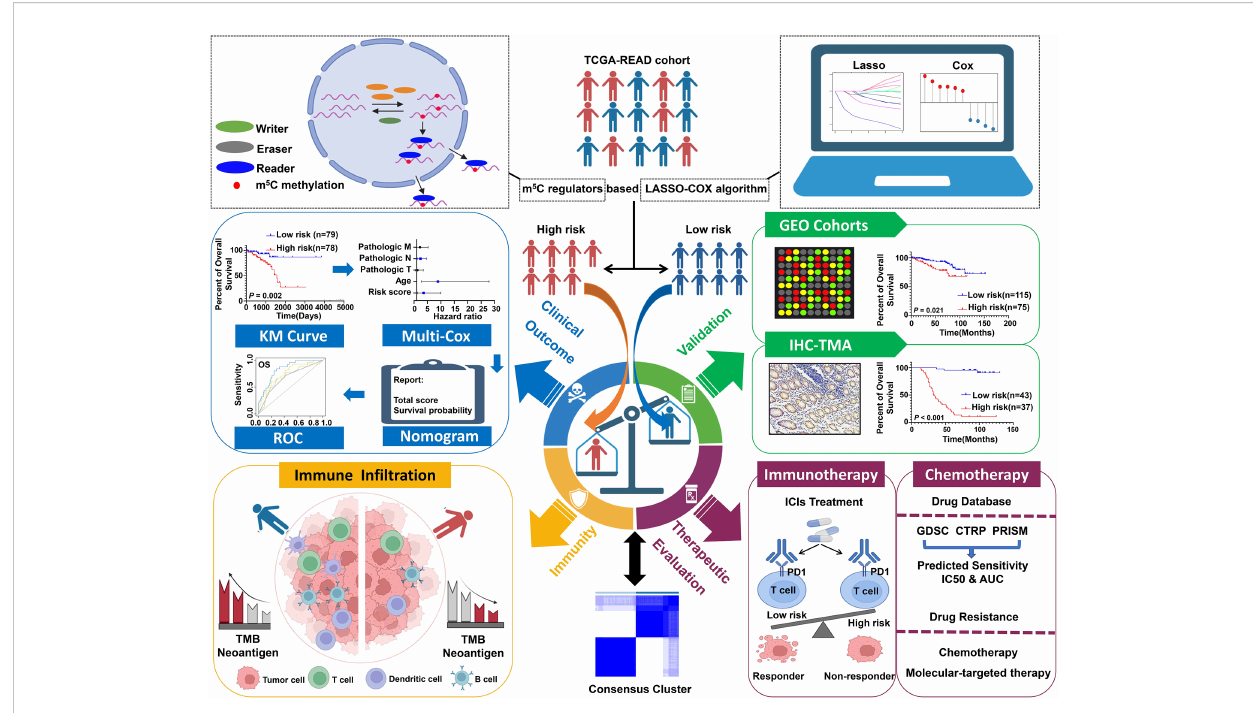
FIGURE 1 Schematic diagram of the study